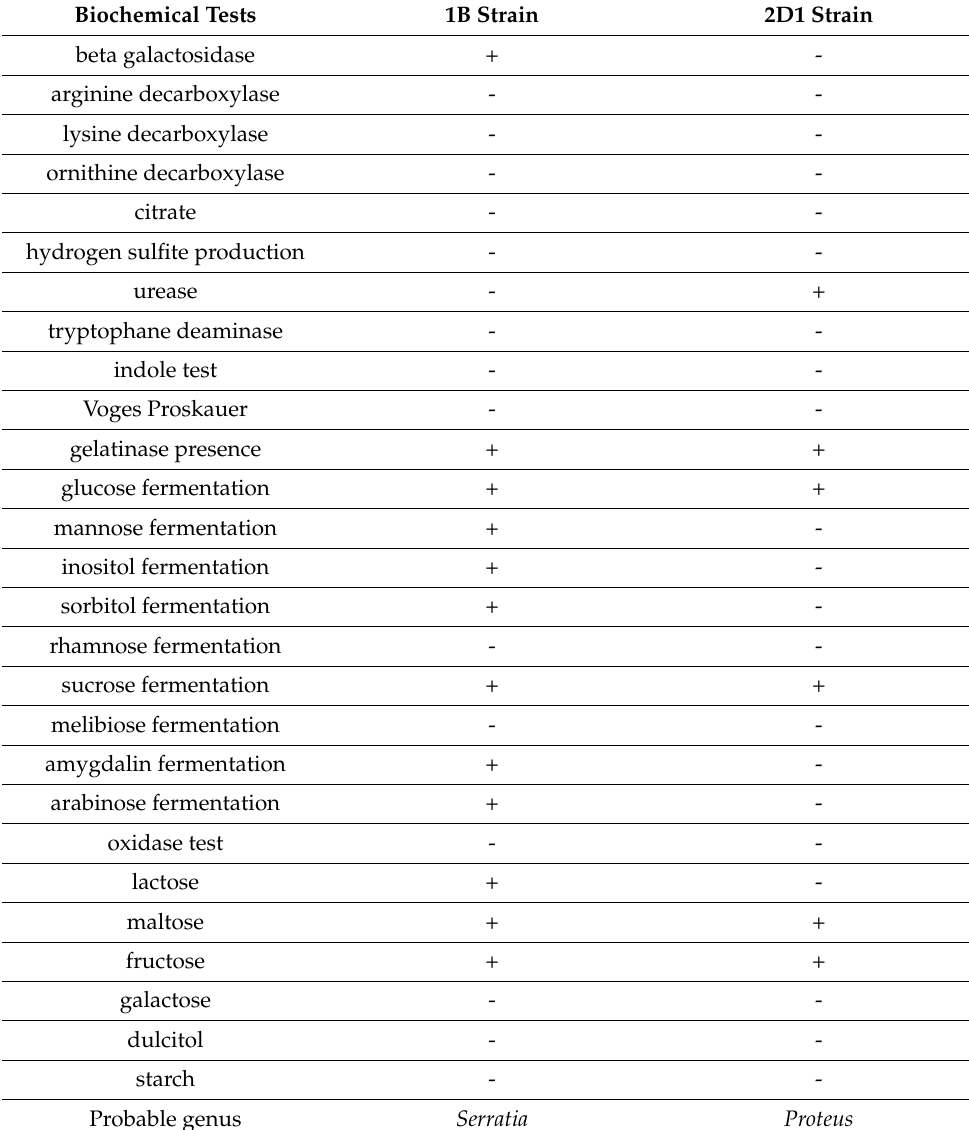
Table 2. Provisional identification of the PHB producers 1B and